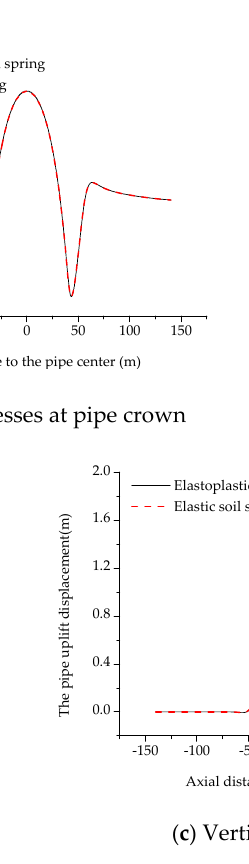
Figure 8. Results for a liquefaction zone length equal to 30 m.